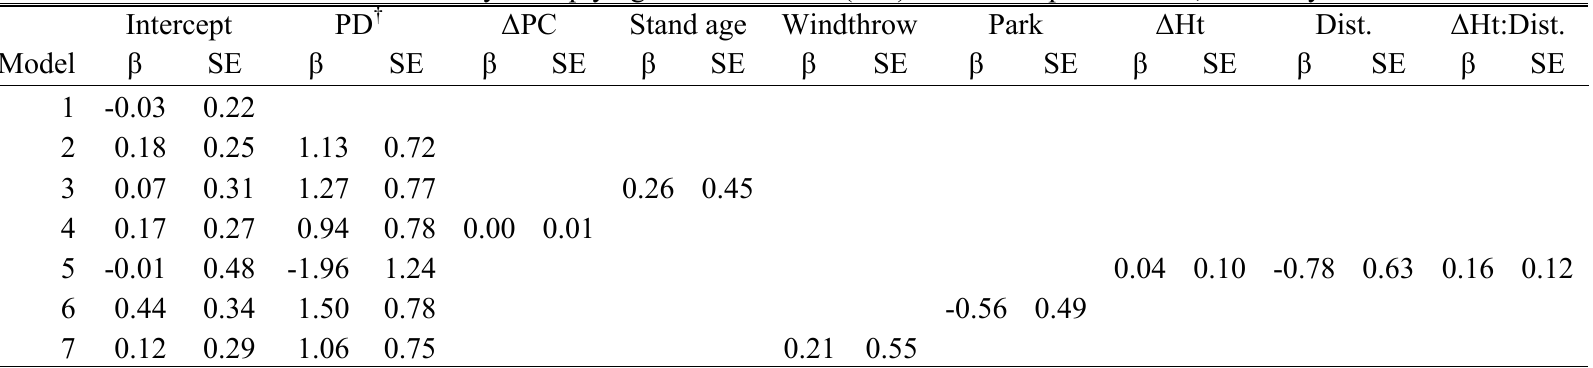
Table A2.2 Parameter estimates for models examining variation in stand-level trends (between circa 1994 and 2014) in abundance Ruby- crowned Kinglet in aspen dominated mixedwood forests in central Saskatchewan. 85% Confidence Intervals can be obtained as β ± 1.44* SE. NOTE: Parameter values were rescaled by multiplying with a constant (100) for ease of presentation, divide by 100 to obtain estimates.